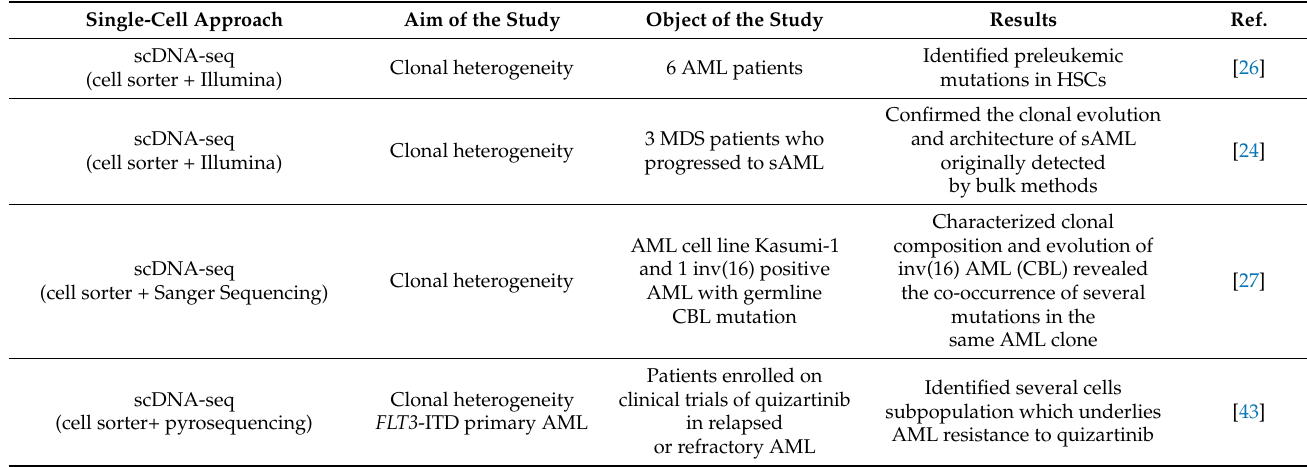
Table 1. Overview of single-cell sequencing studies in